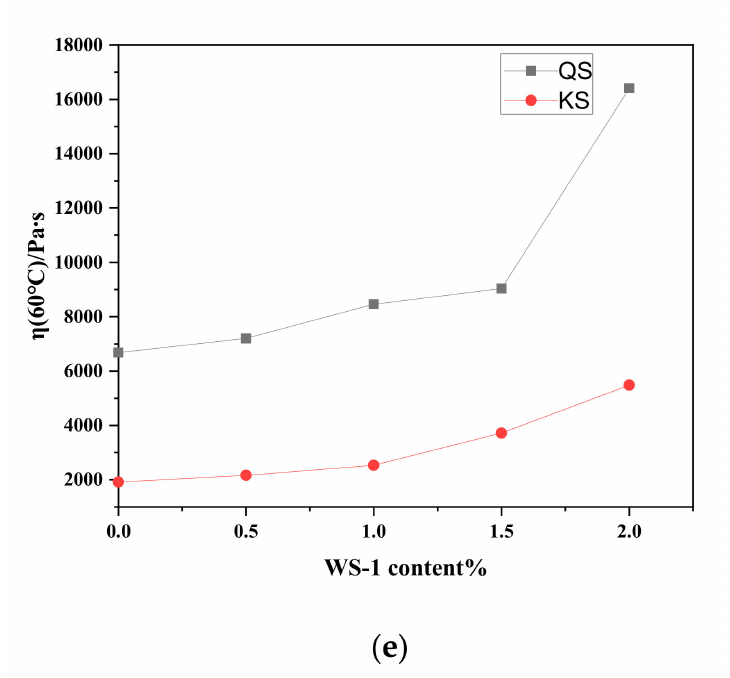
Figure 2. Effect of WS-1 on conventional properties of rubber asphalt: ( a ) penetration; ( b ) softening point; ( c ) elastic recovery; ( d ) ductility; ( e ) viscosity (60 ◦